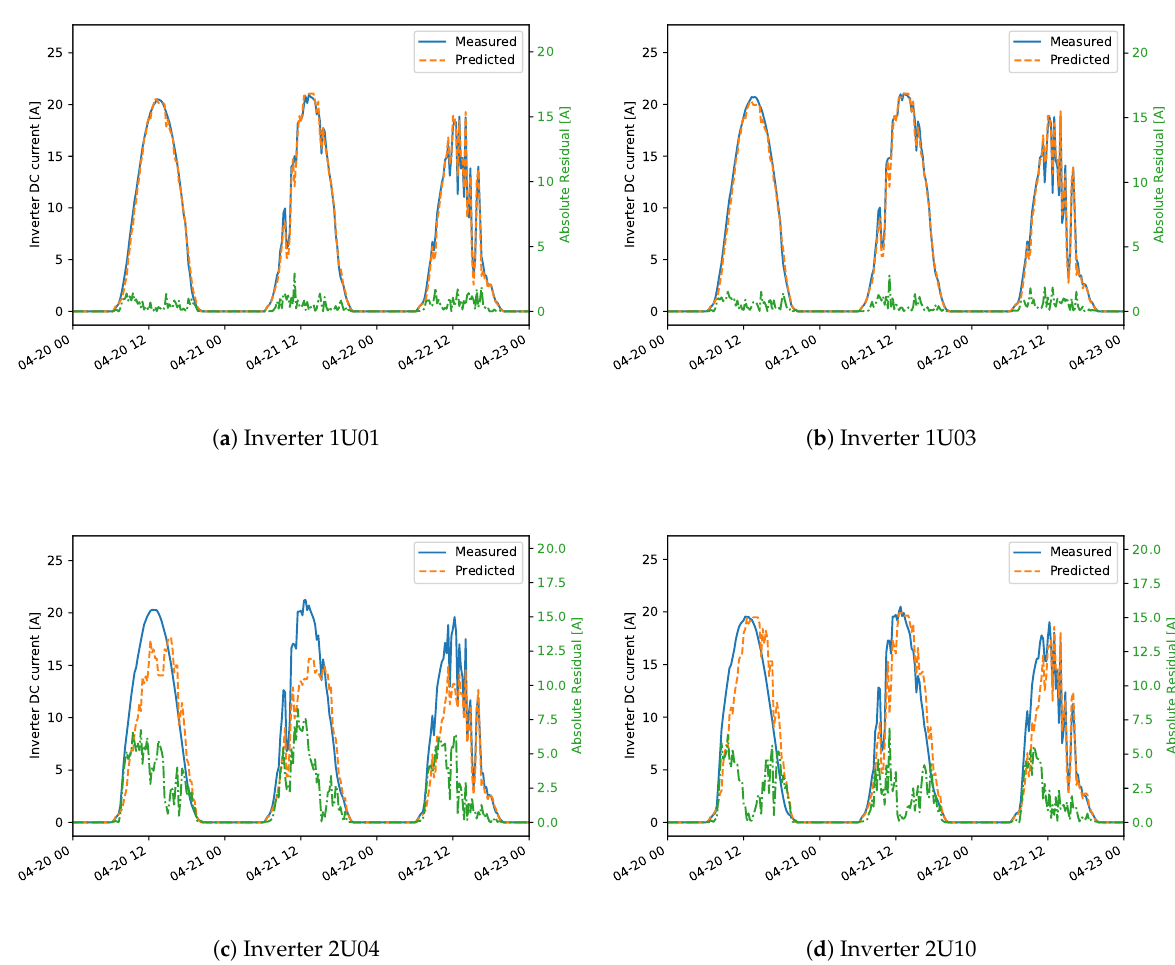
Figure 9. Detail for two inverters from plant A showing both the measured and predicted DC currents. The residuals are also shown (green dash-dotted line, right